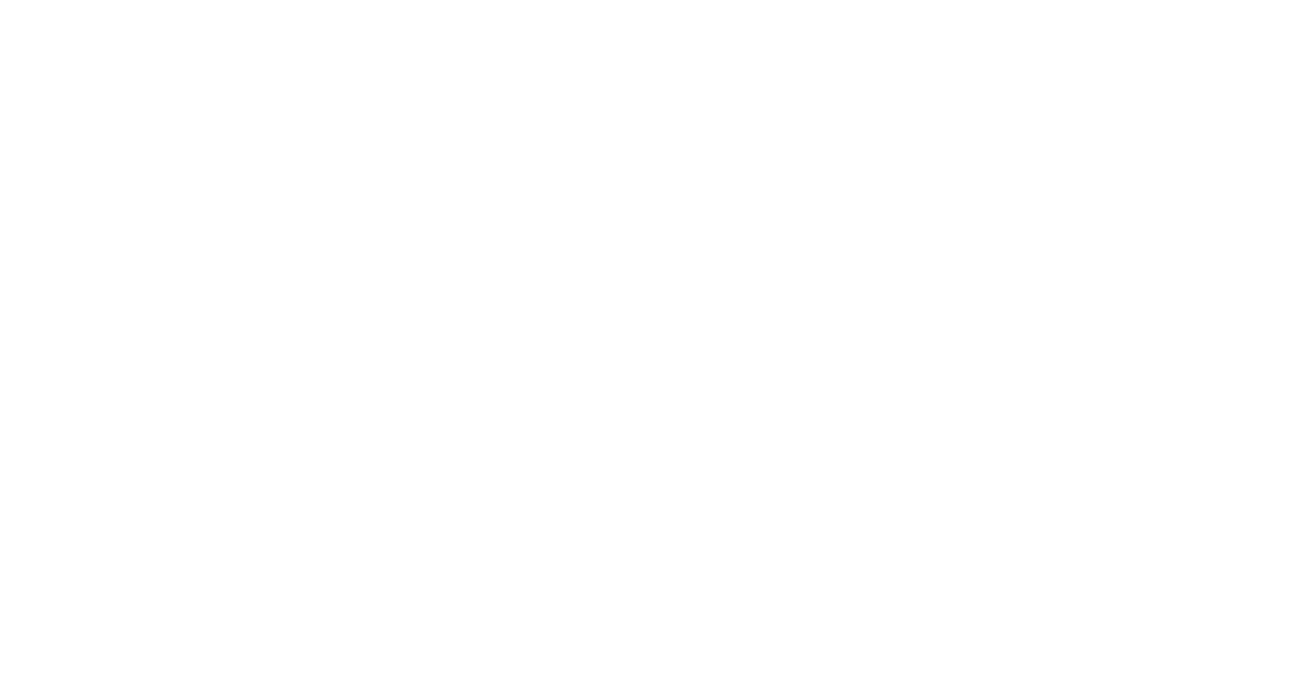
Frontiers in Plant Science | Plant